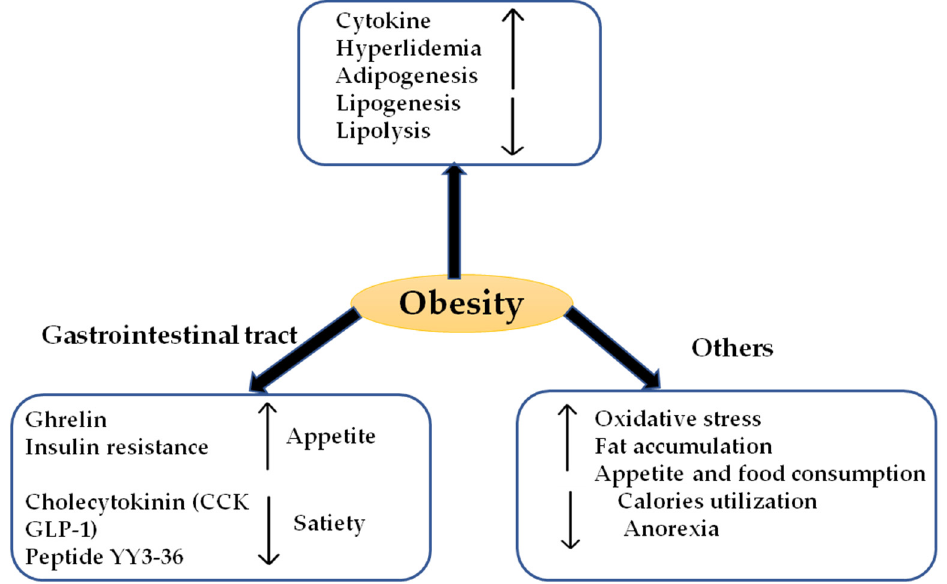
Figure 1. Obesity regulatory